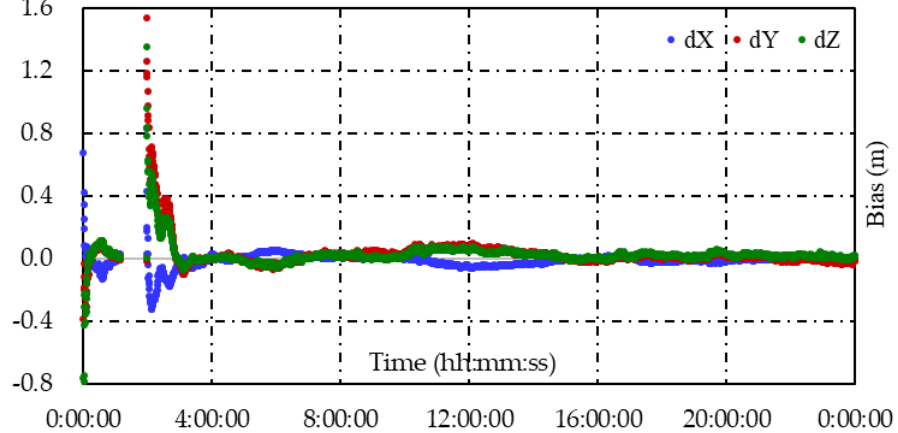
Figure 10. Coordinate biases from kinematic PPP with method A.